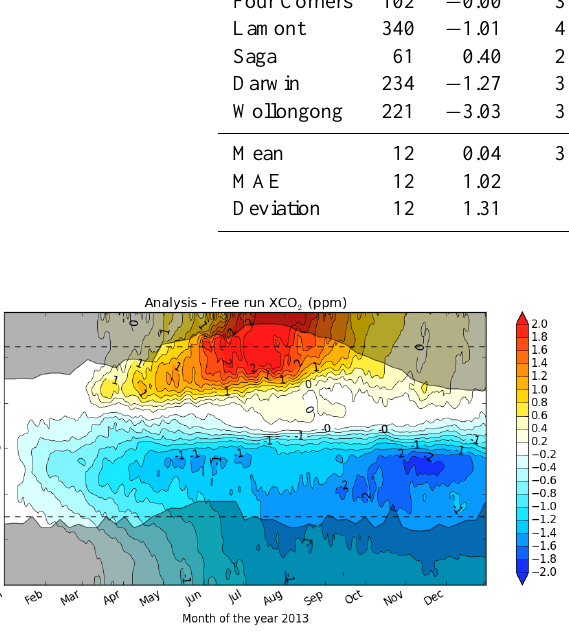
Figure 5. Hovmöller diagram (latitude vs. time) of the difference in ppm (negative/positive in blue/red) between XCO 2 from the analy- sis and from the free-run simulation, from 1 January to 31 Decem- ber 2013. The horizontal dotted lines represent the latitude of the northernmost and the southernmost TCCON station, respectively. The grey shaded areas are where GOSAT does not provide observa-